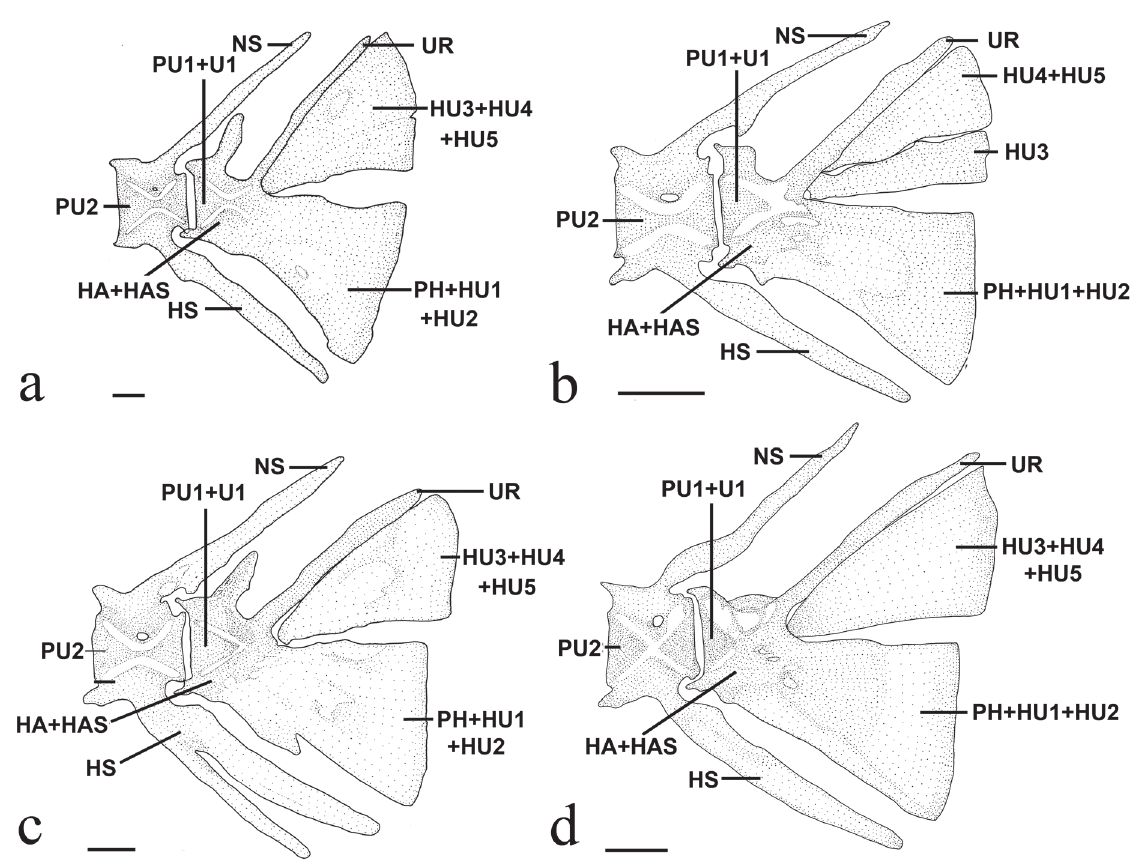
Fig. 6. Lateral view, anterior to left, of caudal skeleton of ( a ) Trichomycterus balios , paratype, UFRGS 6831, 81.7 mm SL; ( b ) T . diatropoporos , paratype, UFRGS 16237, 57.8 mm SL; ( c ) T . poikilos , paratype, MCP 22699, 79.0 mm SL; and ( d ) T . brachykechenos , paratype, UFRGS 16244, 51.6 mm SL. Abbreviations: HA+HAS, complex hypurapophysis composed